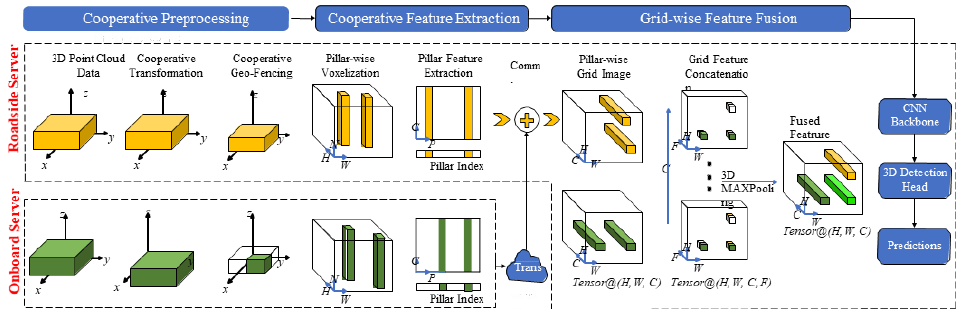
Figure 7. The system architecture of a feature-based cooperative perception framework [90].